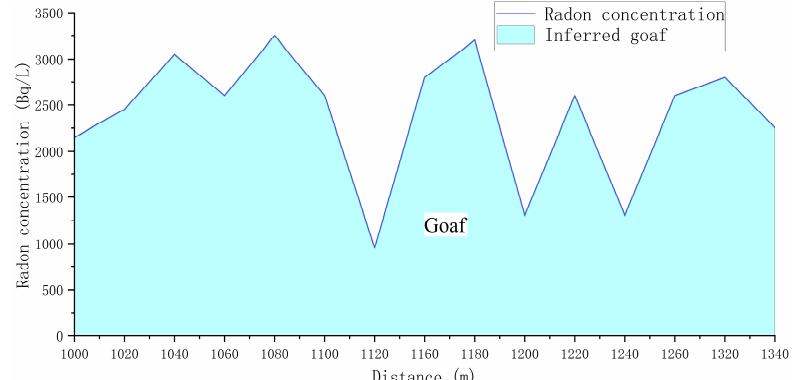
Figure 13. Profile Map of Radon Measurement by Activated Carbon for Survey Line L10.